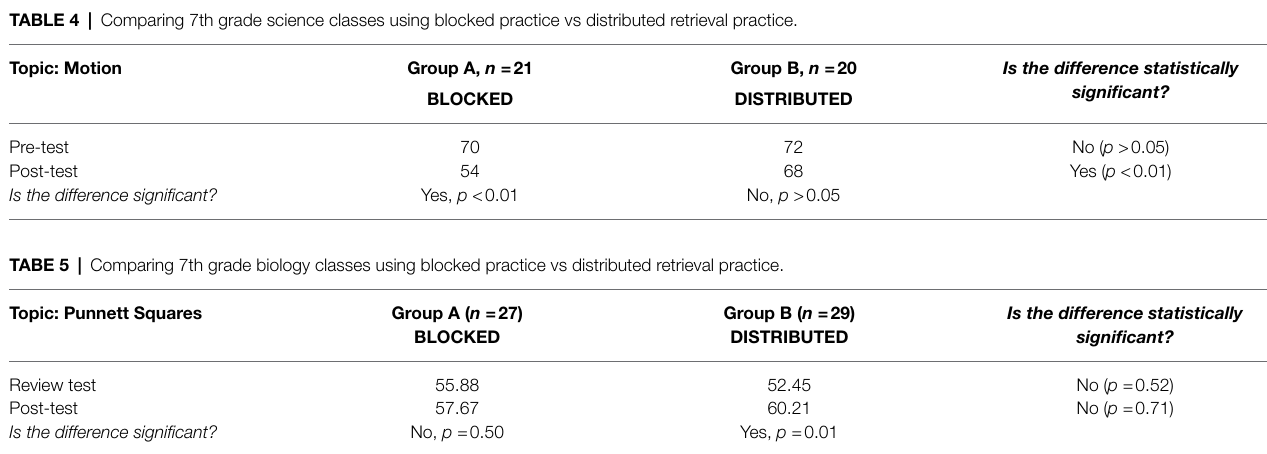
TABLE 6 | Comparing 7th grade earth sciences classes using blocked practice vs distributed retrieval practice. Topic ↓